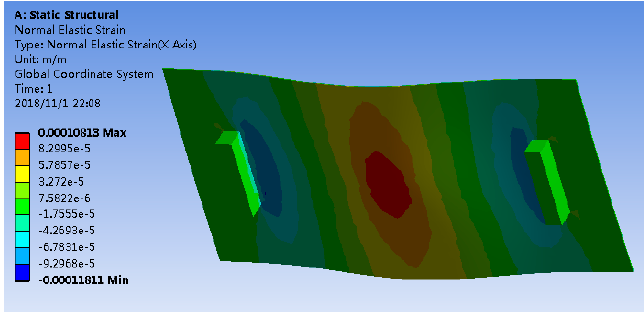
Figure 6. Normal strain distribution corresponding to 60 N from simulation.